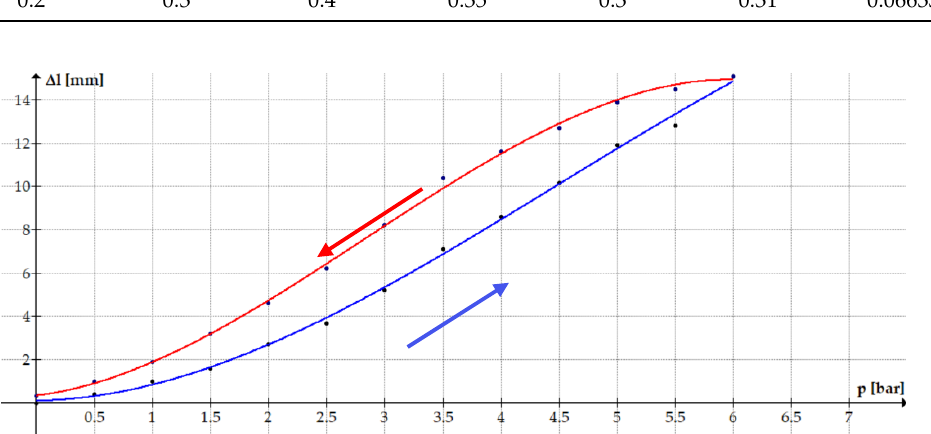
Figure 4. Evolution of the axial contraction versus pressure (no load).